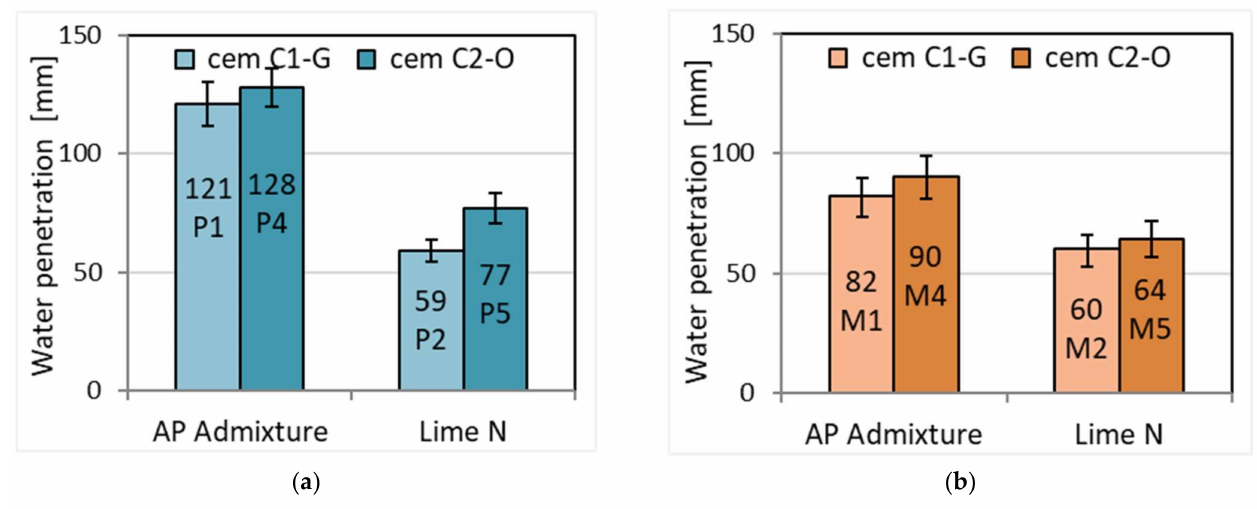
Figure 6. Depth of water penetration under pressure in ( a ) plasters and ( b ) masonry